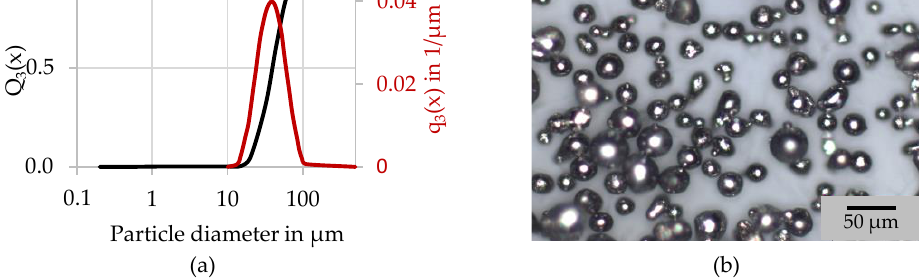
Figure 2. ( a ) Particle size distribution, ( b ) light microscope image of the particle form [16].